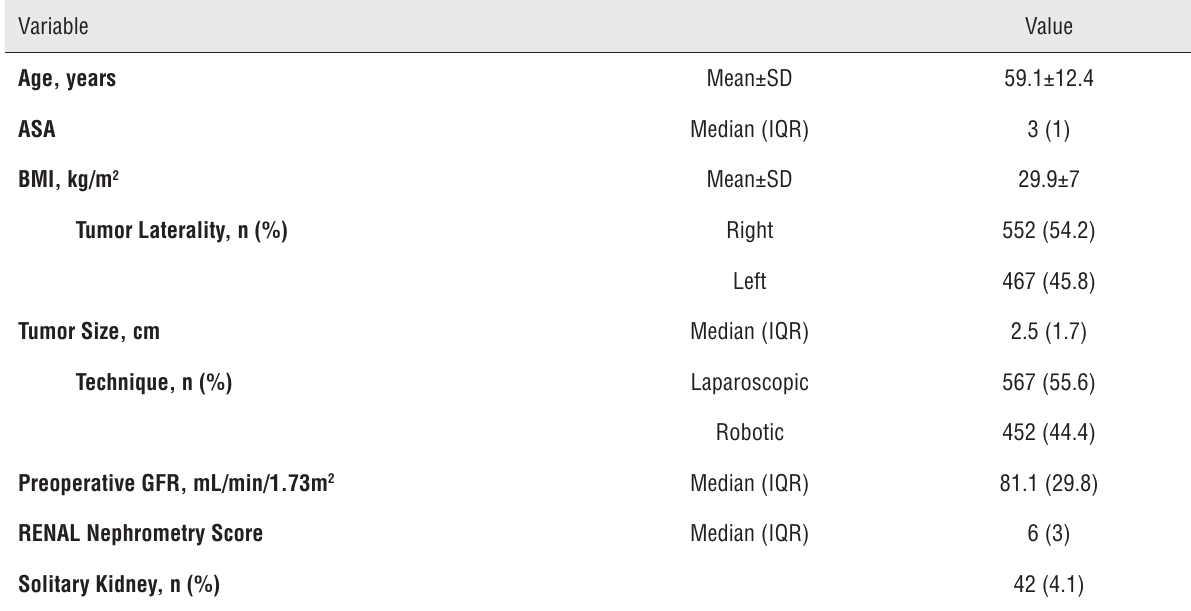
Table 1 - Population Demographics (n=1019).